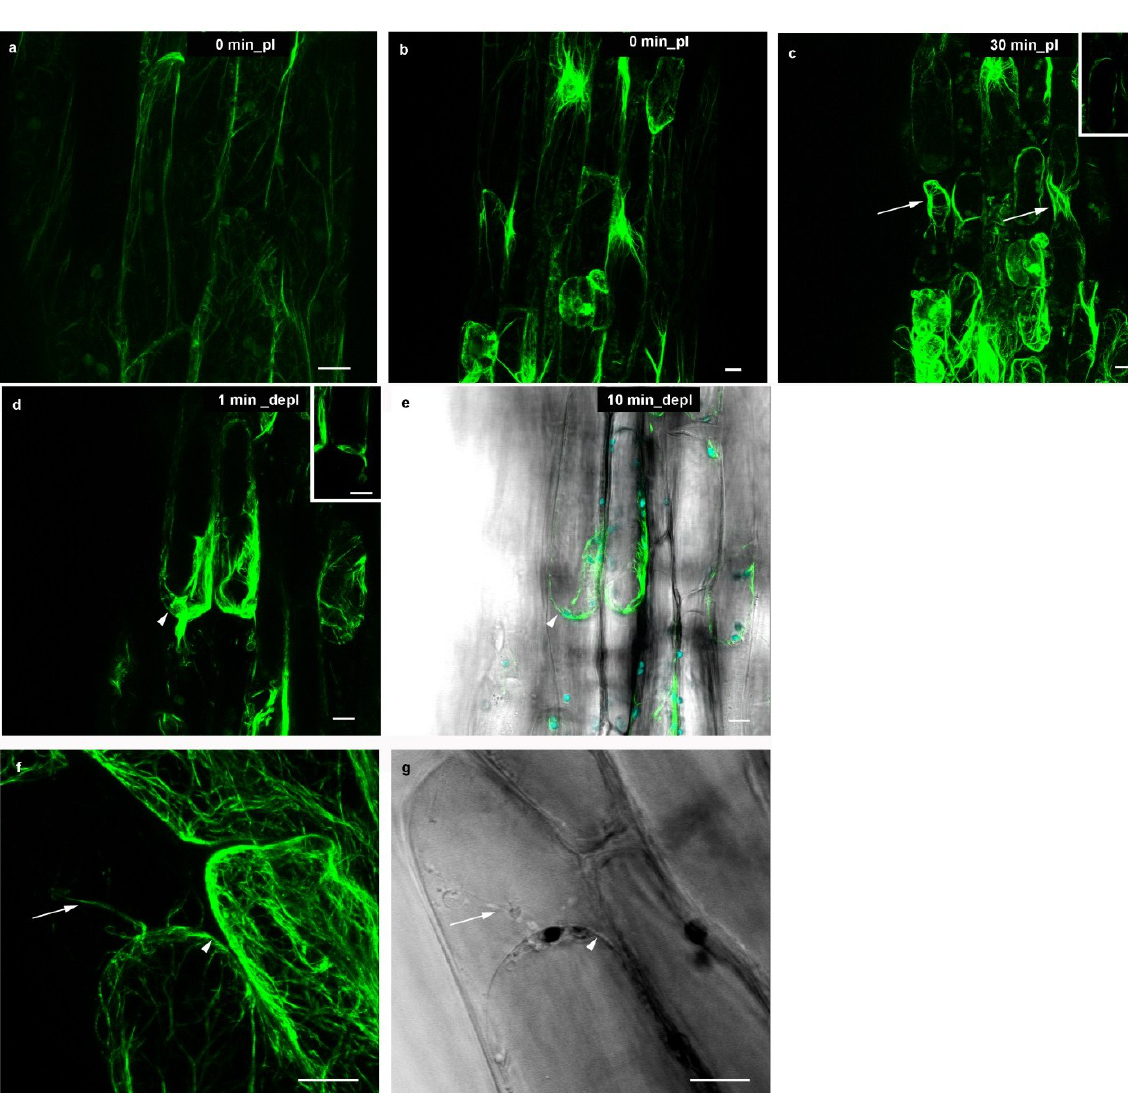
Figure 4. Actin microfilaments (GFP-ABD) in Arabidopsis hypocotyl cells during a plasmolytic cycle; plasmolysis/deplasmolysis times marked on the micrographs. ( a , b ) Before plasmolysis, actin microfilaments were located in the cortical cytoplasm ( a ) and radiated from the nucleus ( b ); ( c ) In the plasmolysed state, actin microfilaments conserved this structure, but also lined the detached plasmalemma regions (arrows); ( d ) The protoplast rounded up at the onset of deplasmolysis, incorporating Hechtian strands (arrowheads) and ( e ) a “stabilizing layer” of bundled actin microfilaments followed the expanding protoplast; ( f , g ) High magnification of Hechtian strands (arrows) with actin microfilaments ( f ) and the corresponding bright field image ( g ), 30 min of plasmolysis in 0.8 M manntiol; arrowheads indicate the plasma membrane. Inserts ( c , d ): Single focal planes to show the cortical array. Bar: 10